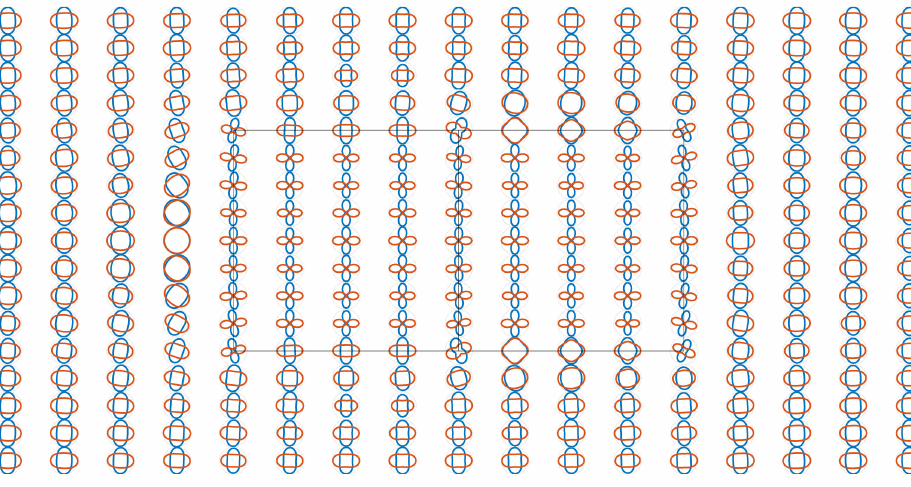
Figure 22. Polar plots of modified COMMEMI 3D-2A model for 0.01